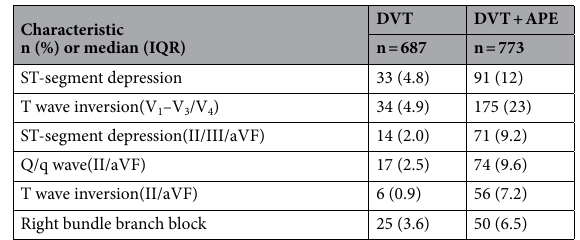
Table 1. Demographic and clinical characteristics of the study patients. ECG electrocardiogram, APE acute pulmonary embolism, DVT deep vein thrombosis, VTE venous thromboembolism, P2 pulmonary valve second heart sound.